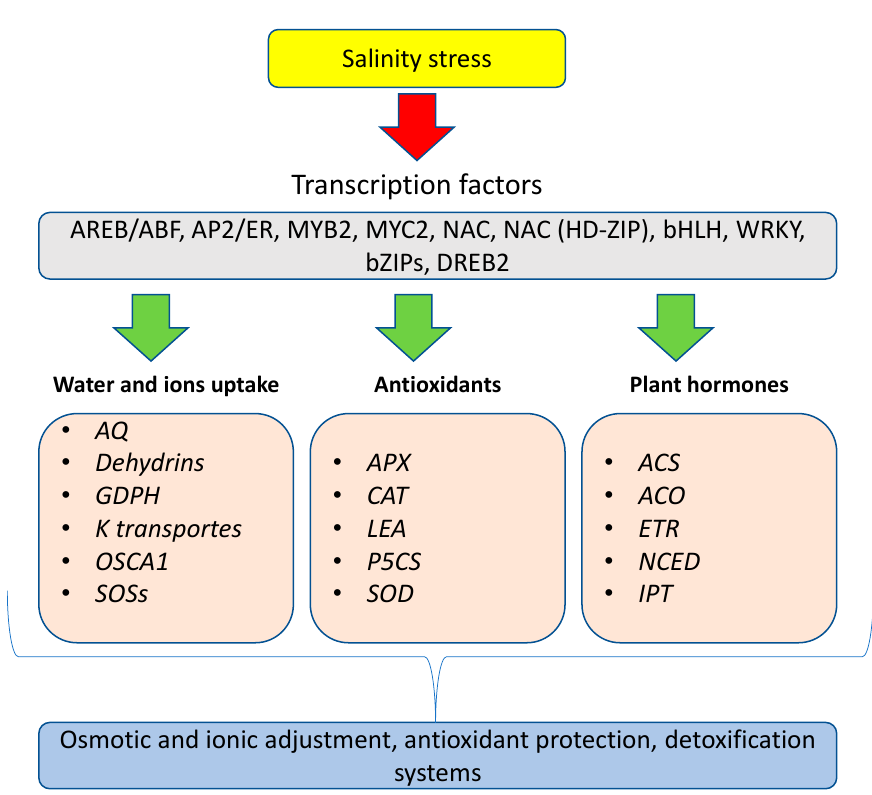
Figure 4. The first crop salinity responses at the molecular level involve the expression of transcription factors that activate the regulatory genes responsible for the activation of secondary genes. These clusters of genes are involved in water and ion uptake, the production of antioxidant enzymes, and plant hormones biosynthesis.